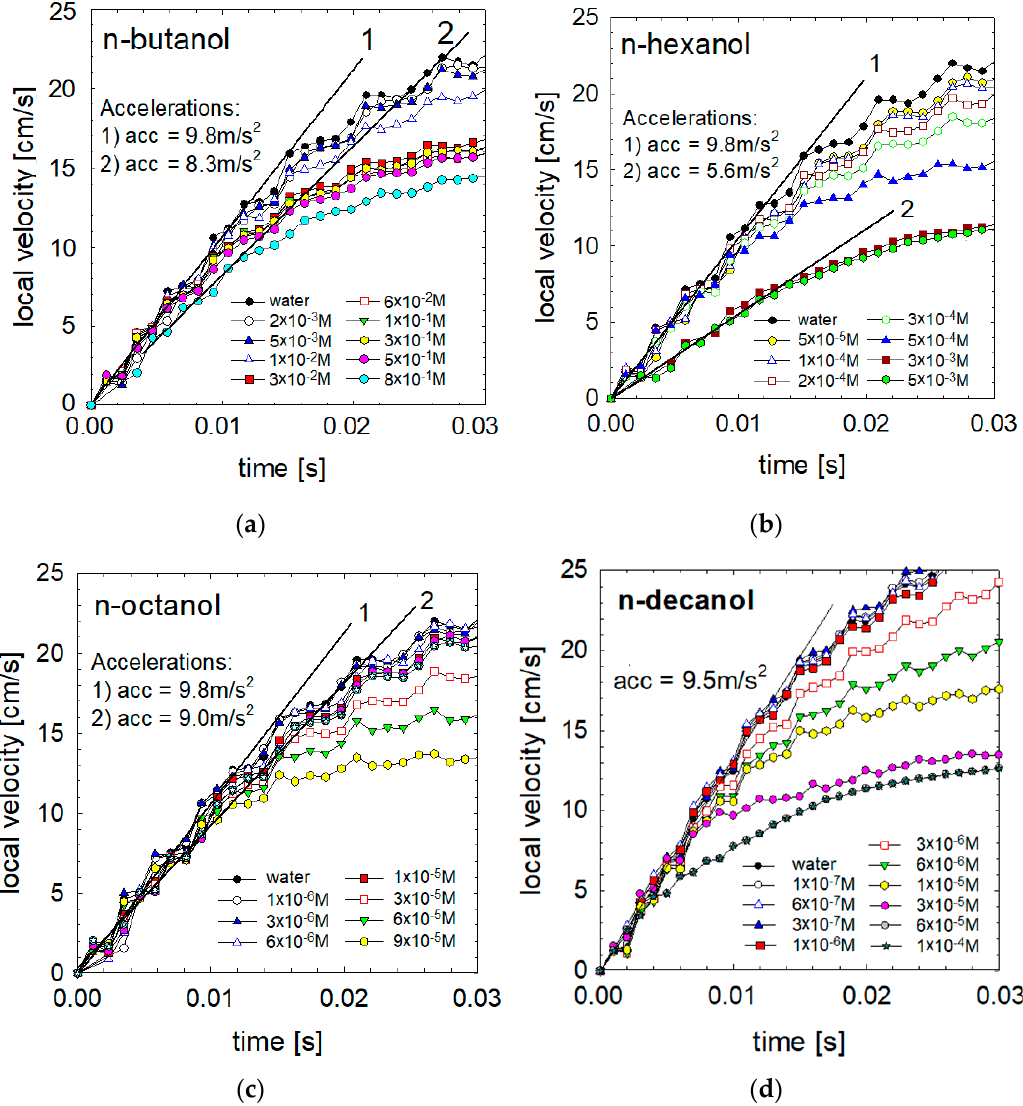
Figure 3. Detailed velocity profiles (for acceleration stage of motion) as a function of ( a ) n-butanol, ( b ) n-hexanol, ( c ) n-octanol and ( d ) n-decanol solutions of different concentrations. Slopes of lines 1 and 2 correspond to the initial acceleration of few chosen cases.